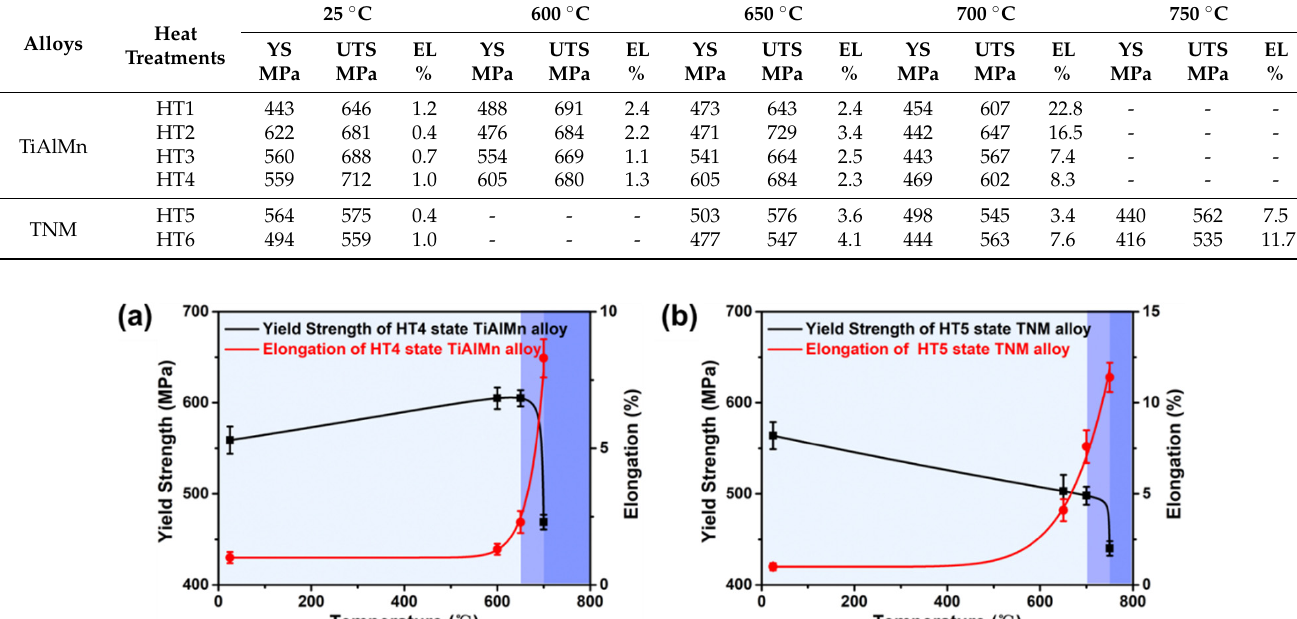
Figure 10. The optimal tensile properties of the heat-treated TiAlMn alloy and TNM alloy as a function of the testing temperature: ( a ) HT4 state TiAlMn alloy, ( b ) HT5 state TNM alloy.